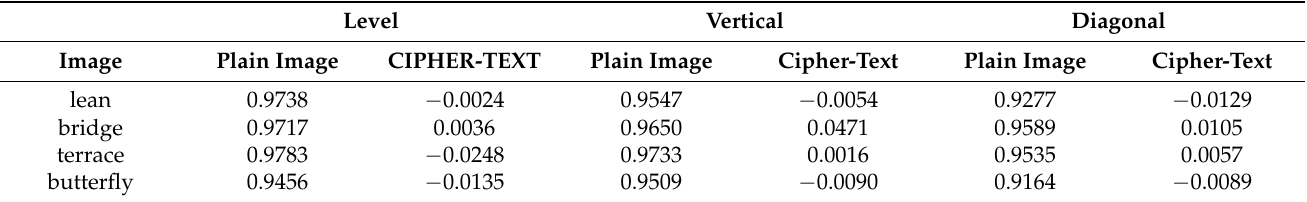
Table 5. Correlation coefficient.